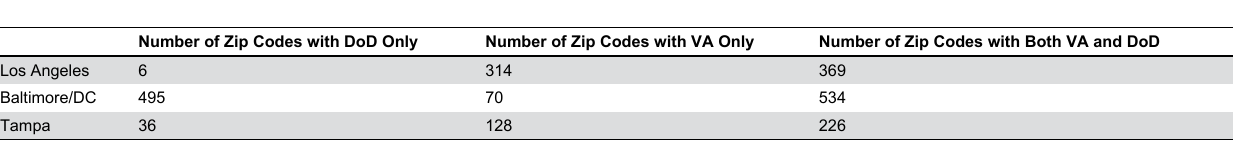
Table 3. Number of zip codes represented by metropolitan area for case clusters combining Department of Defense (DoD) and Veterans Affairs (VA) datasets from October 1, 2006 - September 30, 2010.